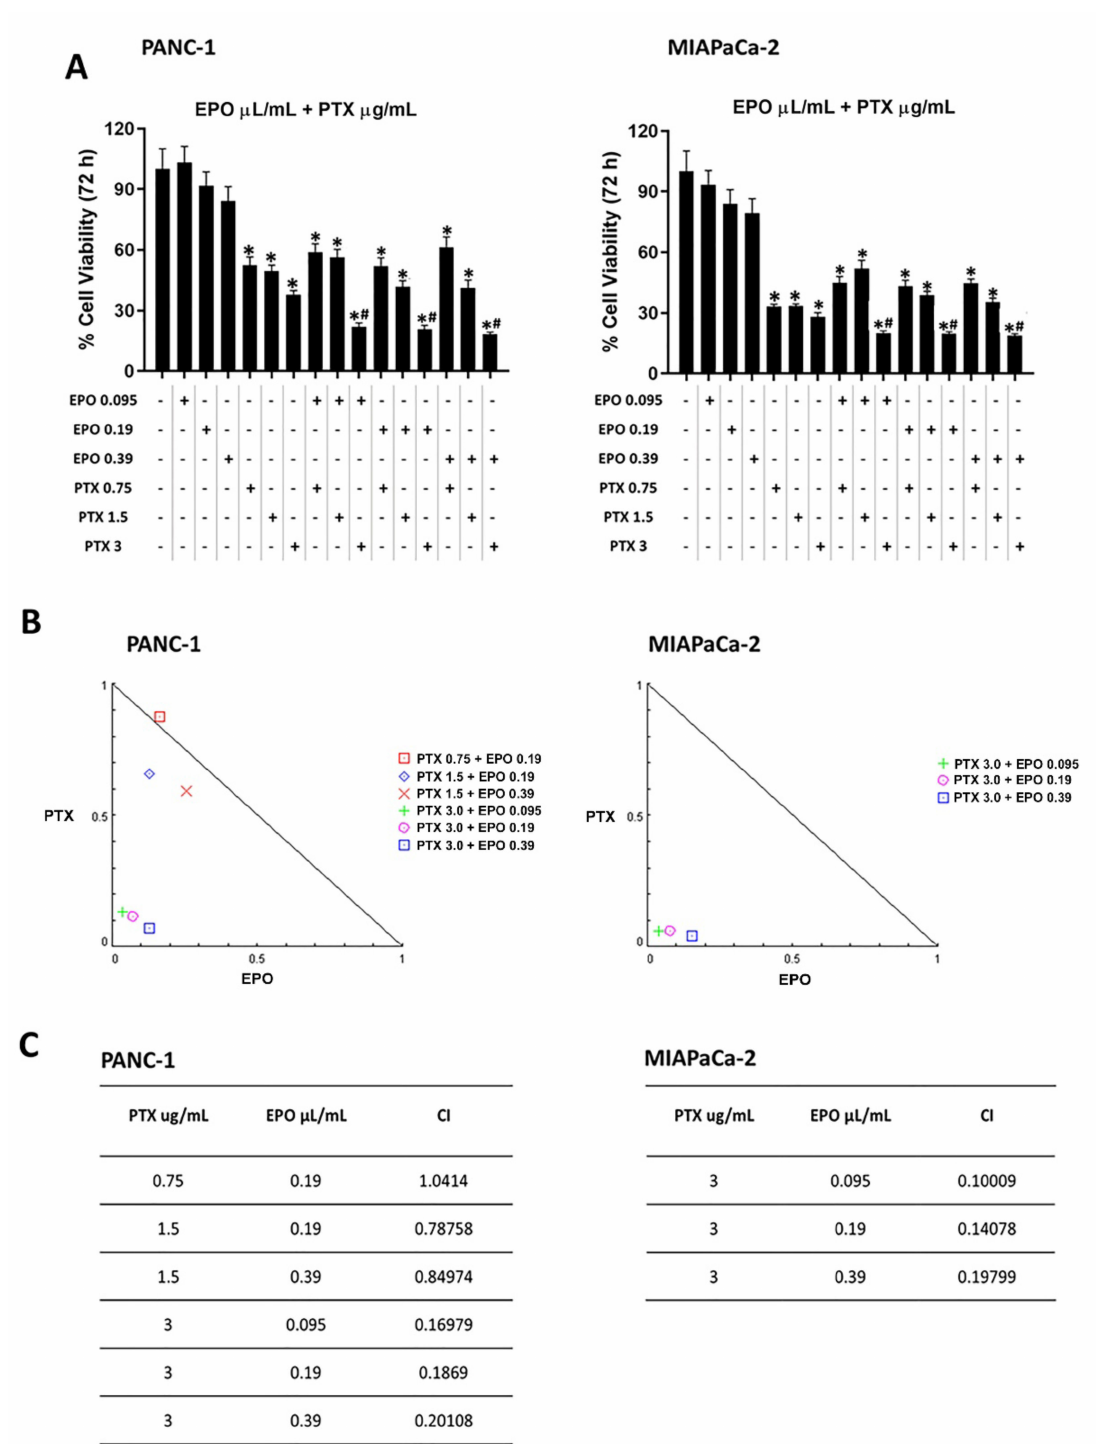
Figure 6. Evaluation of the effect of PTX and EPO combinations in PANC-1 and MIAPaCa-2 cells. ( A ) PANC-1 and MIAPaCa-2 cell viability after treatment with different combinations of PTX and EPO. Data shown are expressed as the mean ± SD of three separate experiments. * p < 0.05 treated PANC-1 or MIAPaCa-2 vs. vehicle, # p < 0.05 treated PANC-1 or MIAPaCa-2 vs. PTX alone. ( B ) Isobologram plots for combination treatments of PTX and EPO in PANC-1 and MIAPaCa-2 cell lines. Lower left of the hypotenuse, synergism; on the hypotenuse, additive effect; upper right, antagonism. Synergistic activity of PTX-EPO was calculated by CompuSyn Software. ( C ) CI values for PANC-1 and MIAPaCa-2 cell